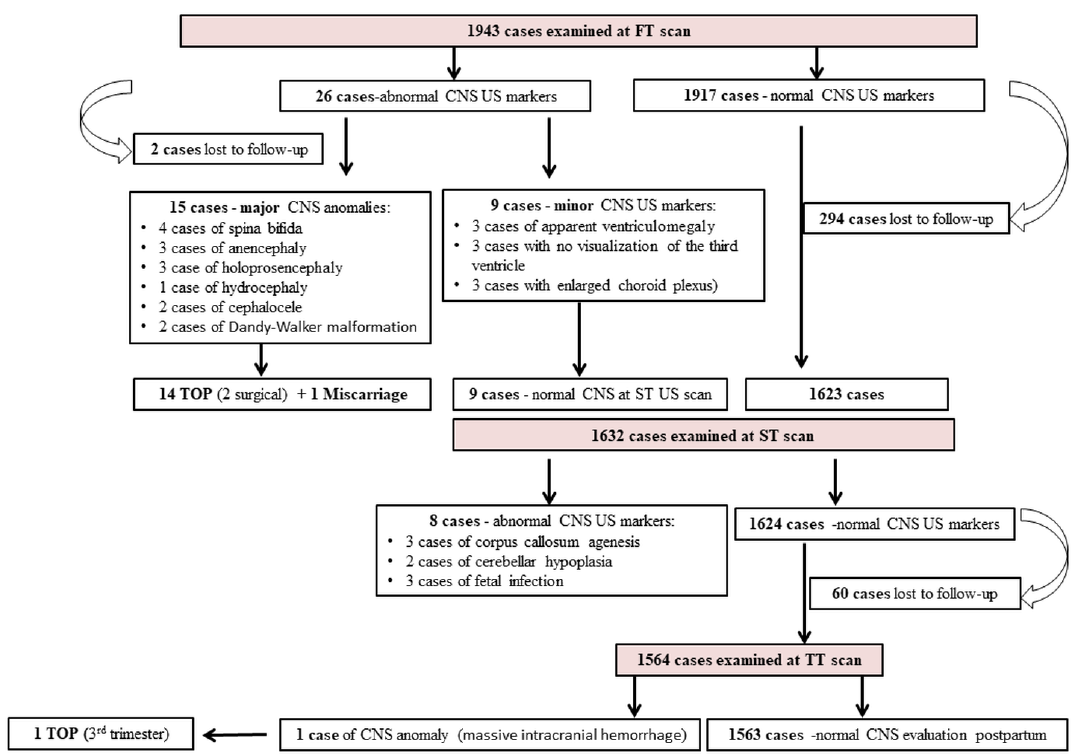
Figure 2. Flowchart summarizing inclusion of cases in the study and outcome after the first trimester (FT), second trimester (ST) and third trimester (TT) evaluations. (CNS—Central nervous system, US—Ultrasound, TOP—Termination of pregnancy).